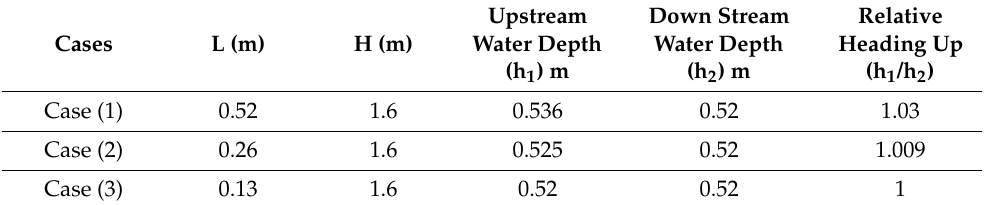
Figure 9. Sectional elevation in the canal where the biofilter was installed at different heights. Table 5. The measured water depths upstream and downstream of the biofilter and the resulting relative heading up (h 1 /h 2 ) for different heights.